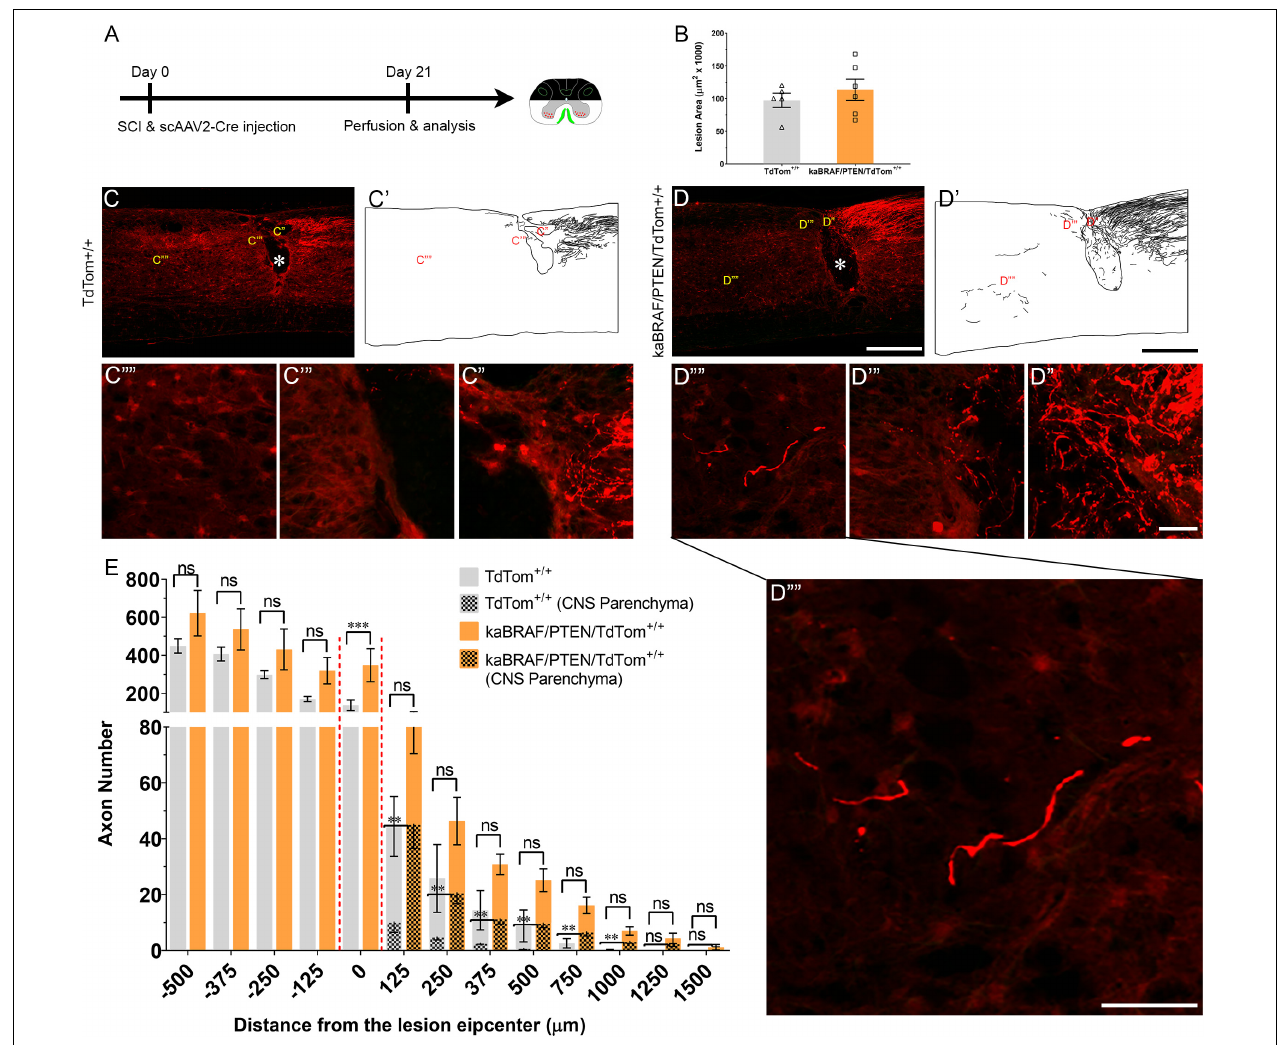
FIGURE 4 | Co-targeting of B-RAF and PTEN immediately after SCI promotes DC axon regeneration. (A) Schematic diagram showing the experimental timeline. Immediately following dorsal SCI scAAV2-Cre was injected into the right L4 and L5 DRGs to induce B-RAF activation and PTEN deletion in LSL-kaBRAF:PTEN f / f :R26-TdT mice. scAAV2-Cre induction is also used to label regenerating DC axons via TdTomato expression upon Cre-mediated recombination in experimental ( LSL-kaBRAF:PTEN f / f :R26-TdT ) and control ( R26-TdT ) mice. (B) Quantitative analysis of the SCI lesion area in LSL-kaBRAF:PTEN f / f :R26-TdT versus R26-TdT mice. (C–C (cid:48)(cid:48)(cid:48)(cid:48) ) Representative images of a R26-TdT mouse spinal cord showing lack of DC axon regeneration within the lesion epicenter. Most axons stop at the caudal astroglial border of the injury site and rarely penetrate the lesion epicenter. ∗ Indicates lesion epicenter. (D–D (cid:48)(cid:48)(cid:48)(cid:48) ) Representative images of an LSL-kaBRAF:PTEN f / f :R26-TdT mouse spinal cord showing increased DC axon regeneration. Some regenerating DC axons penetrate the lesion epicenter, and a few extend directly across the rostral astroglial border of the injury site. ∗ Indicates lesion epicenter. (E) Quantitative comparison of regenerated DC axons in LSL-kaBRAF:PTEN f / f :R26-TdT versus R26-TdT mice. Significantly increased DC axon regeneration is evident at the lesion epicenter (0 µ m: ∗∗∗∗ P < 0.0001, df = 9). Two-way ANOVA with repeated measures. [ (E) patterned] Quantitative comparison of regenerated DC axons within CNS parenchyma rostral to the DC crush in LSL-kaBRAF:PTEN f / f :R26-TdT versus R26-TdT mice. Regenerating DC axons are significantly more numerous in LSL-kaBRAF:PTEN f / f :R26-TdT mice at distances > 1,000 µ m rostral to the lesion. 125 µ m: ∗∗ P = 0.0082, df = 9; 250 µ m: ∗∗ P = 0.0079, df = 9; 375 µ